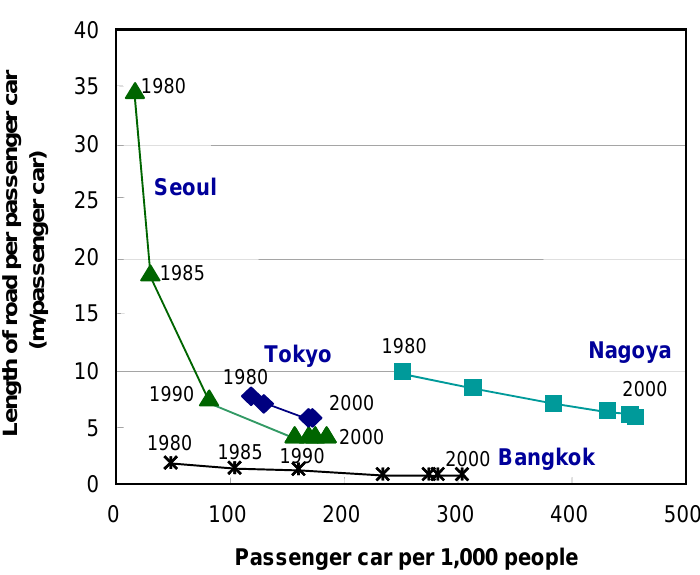
Figure 2. Car ownership v.s. road supply in selected Asian cities